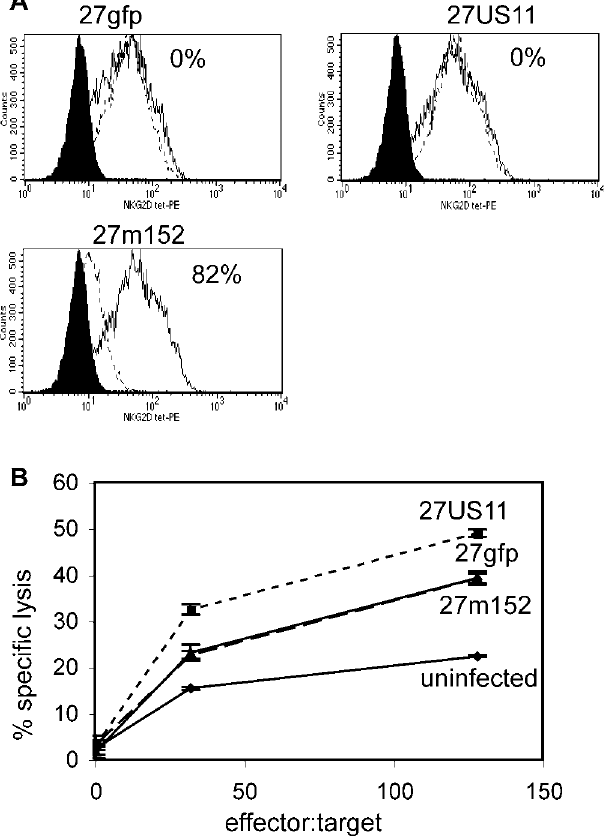
Figure 3. 27m152, but Not 27US11, Evades NK Recognition by Inhibiting NKG2D Ligands (A) BALB/c fibroblasts were uninfected (solid line) or infected (dashed line) for 18 h at an MOI of 5:1 with 27gfp, 27US11, or 27m152 (dashed line) and stained with NKG2D tetramer. Solid histogram is uninfected cells stained with an irrelevant tetramer. The percentage reduction in mean fluorescent intensity from uninfected to infected cells is indicated. (B) Cells were prepared as in (A) and co-incubated with splenocytes from naı¨ve RAG1 (cid:1) / (cid:1) BALB/c mice treated with polyI:C 24 h earlier at the indicated effector-to-target ratio.